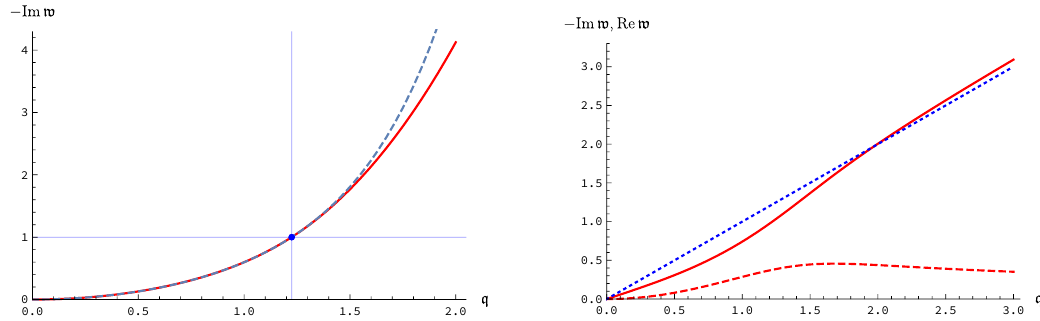
Figure 1 . Dispersion relations of the hydrodynamic modes in the strongly coupled N = 4 SYM theory, obtained using the dual holographic description. The dispersion relations are plotted in terms of dimensionless w (cid:17) != 2 (cid:25)T and q (cid:17) j q j = 2 (cid:25)T , with complex w as functions of real positive q . The left panel shows w shear ( q ) for the shear mode, the right panel shows w + two sound modes. In the left panel, the actual (cid:0) Im w shear ( q ) for the shear mode is shown by the solid red curve, and the analytic hydrodynamic approximation to O ( q 8 ) (computed in section 4.1) is shown by the dashed blue curve. The blue dot indicates the pole-skipping point at q (cid:3) = w (cid:3) = (cid:0) i , discussed in section 4.7. The right panel shows Re w + (cid:0) Im w + ( q ) (dashed red curve) for the \+" sound mode. The straight dotted line indicates the sound light cone Re w = q